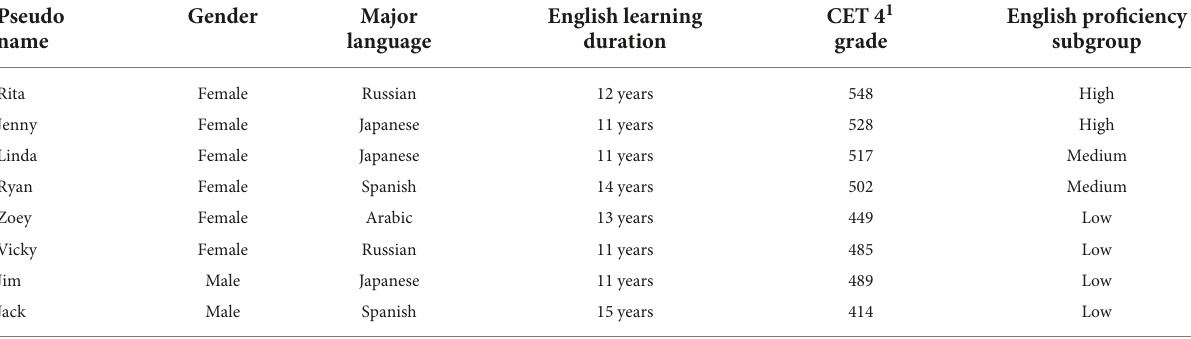
TABLE 1 Participants’ demographic